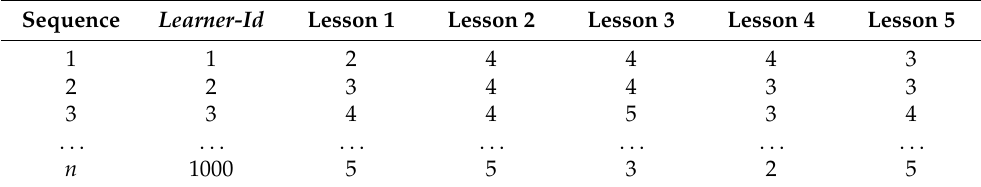
Table 8. Learner profile for Module 1 and Cluster